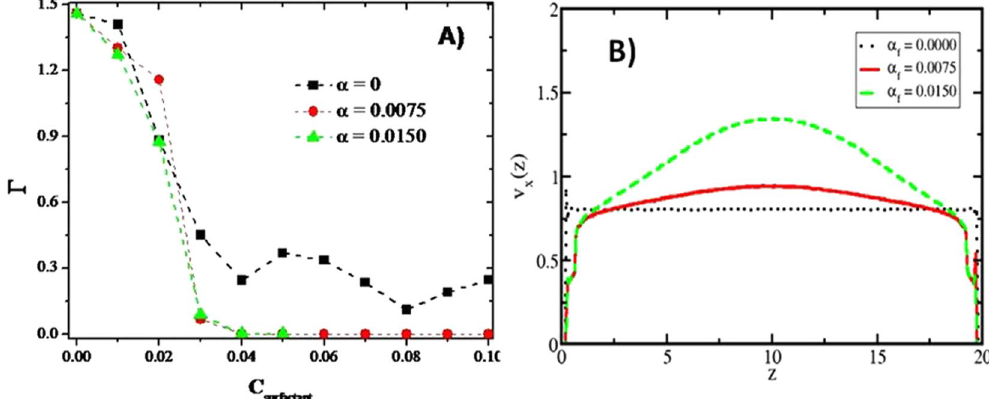
Figure 10. Influence of the flow rate in the desorption process of HC. ( A ) Desorption isotherms (Г) of HC by long nonionic surfactants under three different flow conditions ( α f ). The red line is the same isotherm as that presented in Fig. 5A, and is included here for comparison. (B) Velocity profiles of desorption of HC by long chain nonionic surfactants under three flow conditions ( α f ). For ( A , B) the black (squares in Fig. 10A), red (circles in Fig. 10A) and green (triangles in Fig. 10A) lines correspond to flow conditions equal to α f = 0.0000, 0.0075 and 0.0150, respectively. See Eq. S11 of the SI for details about flow conditions ( α f ). All quantities are reported in reduced DPD